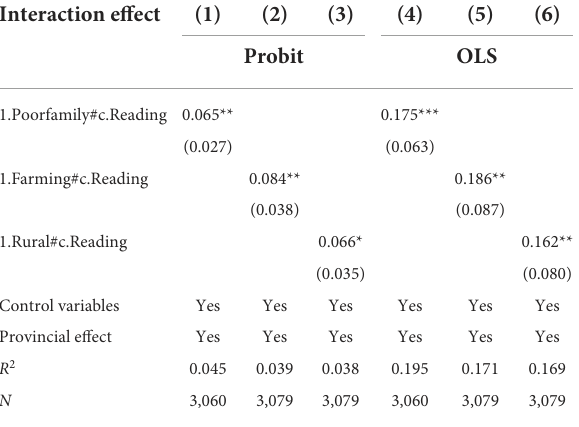
TABLE 9 Heterogeneity